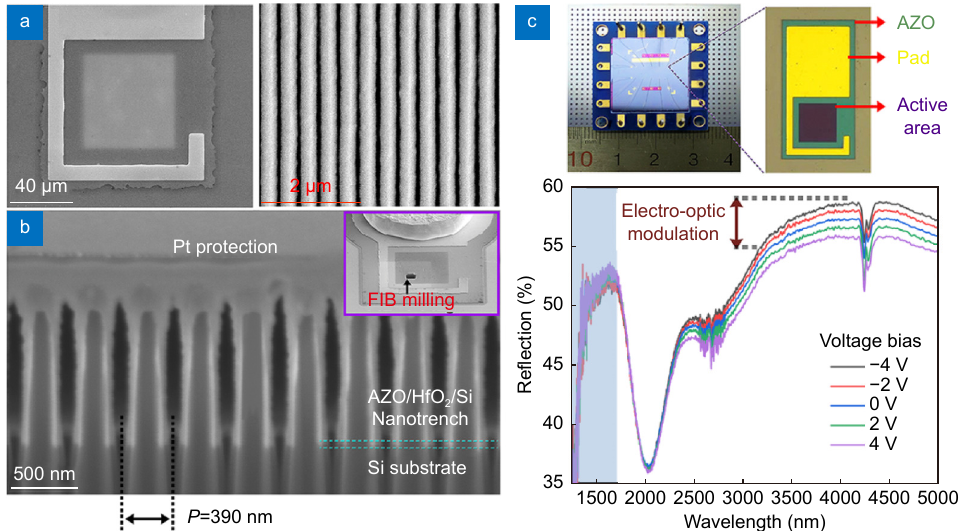
Fig. 2 | ( a ) Top view SEM images of the deepnanotrenchSIS capacitor. ( b ) Side view SEM image of the inner structure of the SIS nano- trenchesafter a section in the central region was milled by FIB.The etched nanowalls were slightly tapered, with the top and bottom widths ran- ging from 110 to 185 nm and the depthestimated to be 1.3 μm. ( c ) The photograph of fabricated device mounted on PCB (left) and the enlarged optical microscopy image of the device area. ( d ) The FTIR measured reflection spectra at various